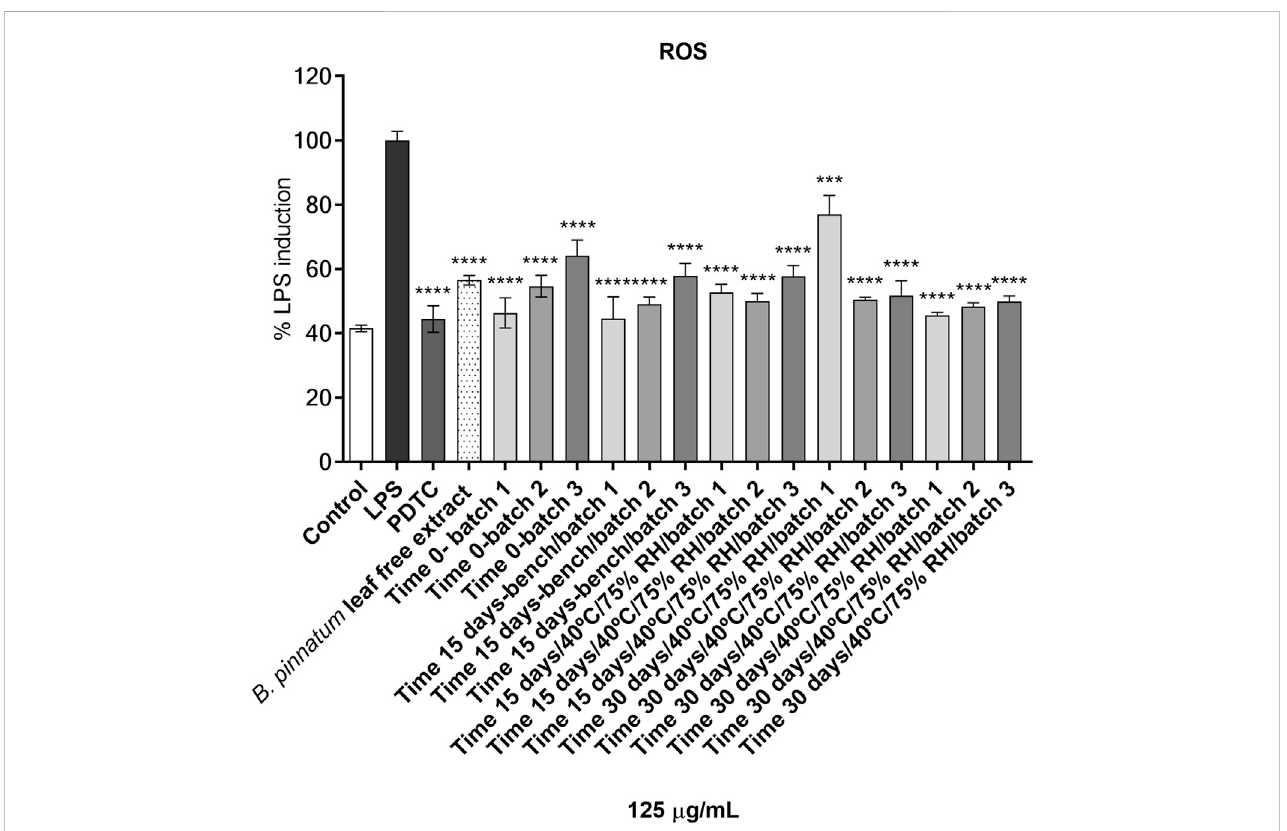
FIGURE 3 The effect on intracellular reactive radical species (ROS) of the B. pinnatum leaf free extract and the solutions extracted from gel containing B. pinnatum leaf extract at 125 μ g/ml on murine macrophage RAW 264.7 cells. ROS production, control (80% ethanol), LPS (100 µg/lipopolysaccharide), PDTC (10 μ M, pyrrolidinedithiocarbamate ammonium); one-way ANOVA was followed by the post hoc Dunnett test. *** p < 0.001, **** p < 0.0001 vs . LPS-treated cells. Bench = room temperature (22 – 25 °